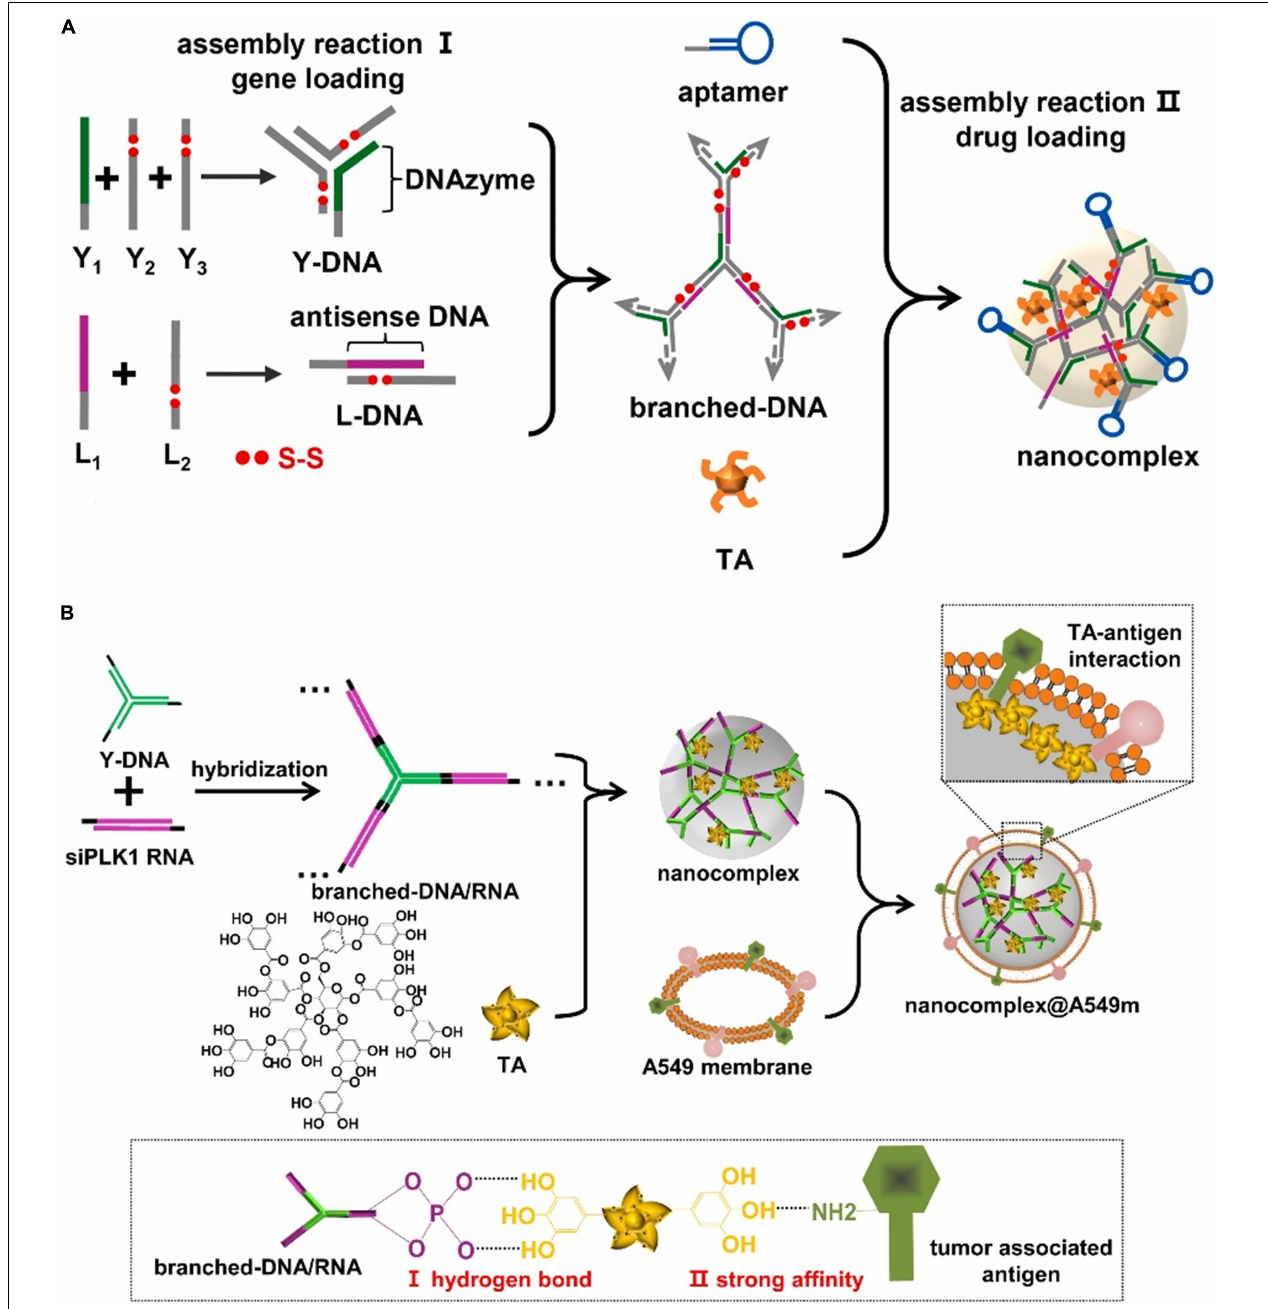
FIGURE 6 | Nanoassembly via TA mediated nucleic acid assembly. (A) DNA-polyphenol nanocomplex for efficient DNAzyme and antisense DNA delivery. Adapted with permission from ref. Han et al. (2021a). Copyright 2021, Elsevier Publishing Group. (B) Nucleic acid nanocomplex through TA mediating self-assembly for smart drug delivery and gene therapy. Adapted with permission from ref. Han et al. (2021b). Copyright 2021, Elsevier Publishing Group.